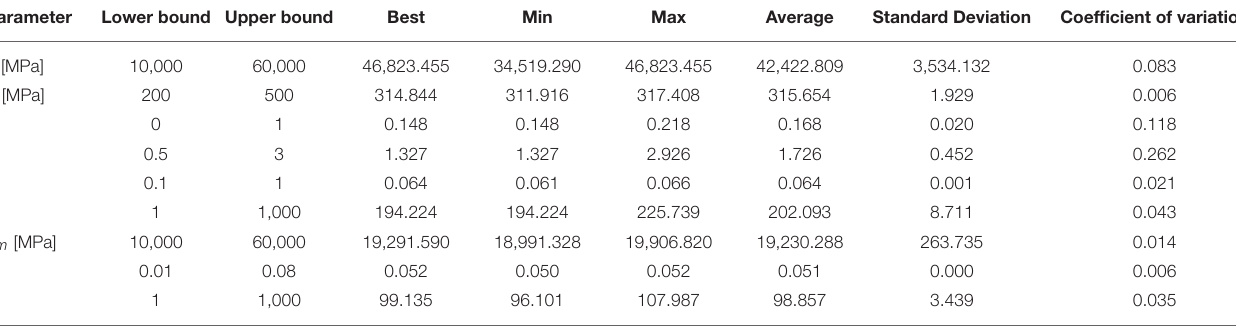
TABLE 2 | Statistical analysis of identified parameters of the proposed model for the experimental data obtained from Zhang and Zhu (2007) shown in Figure 5B . Parameter Lower bound Upper bound Best Min Max Average Standard Deviation Coefficient of variation